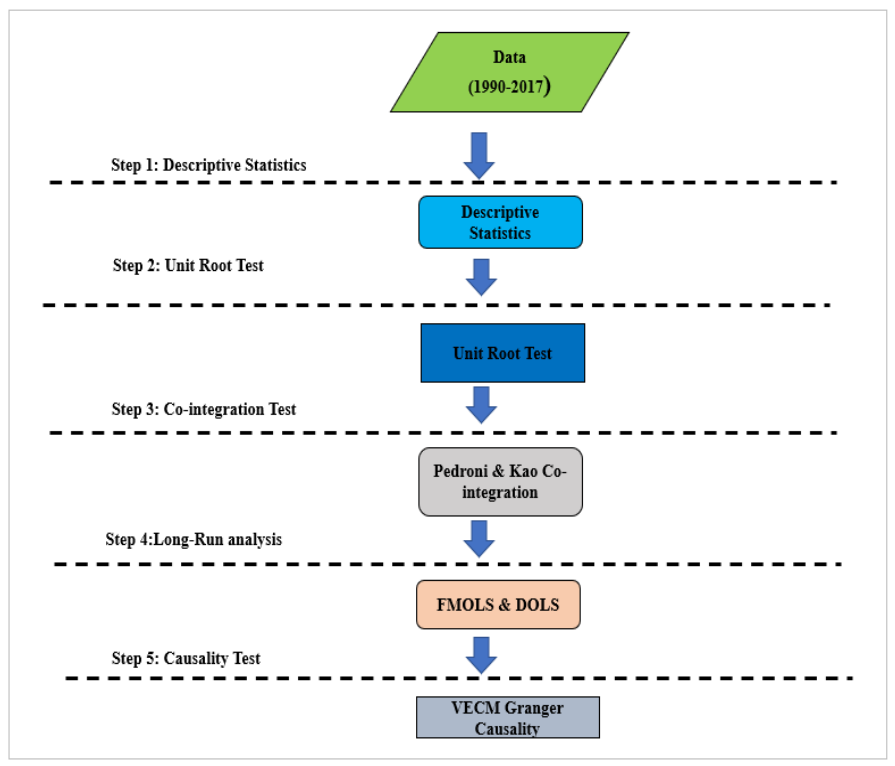
Figure 3. Flowchart of the research methodology.